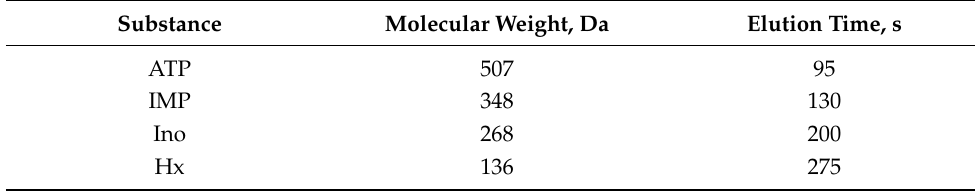
Table 1. Elution times of the main nutritional nucleotides and nucleosides. Figure 4. FPLMC sensor calibration with BSA and the nutritional nucleotides and nucleosides stand- ards.